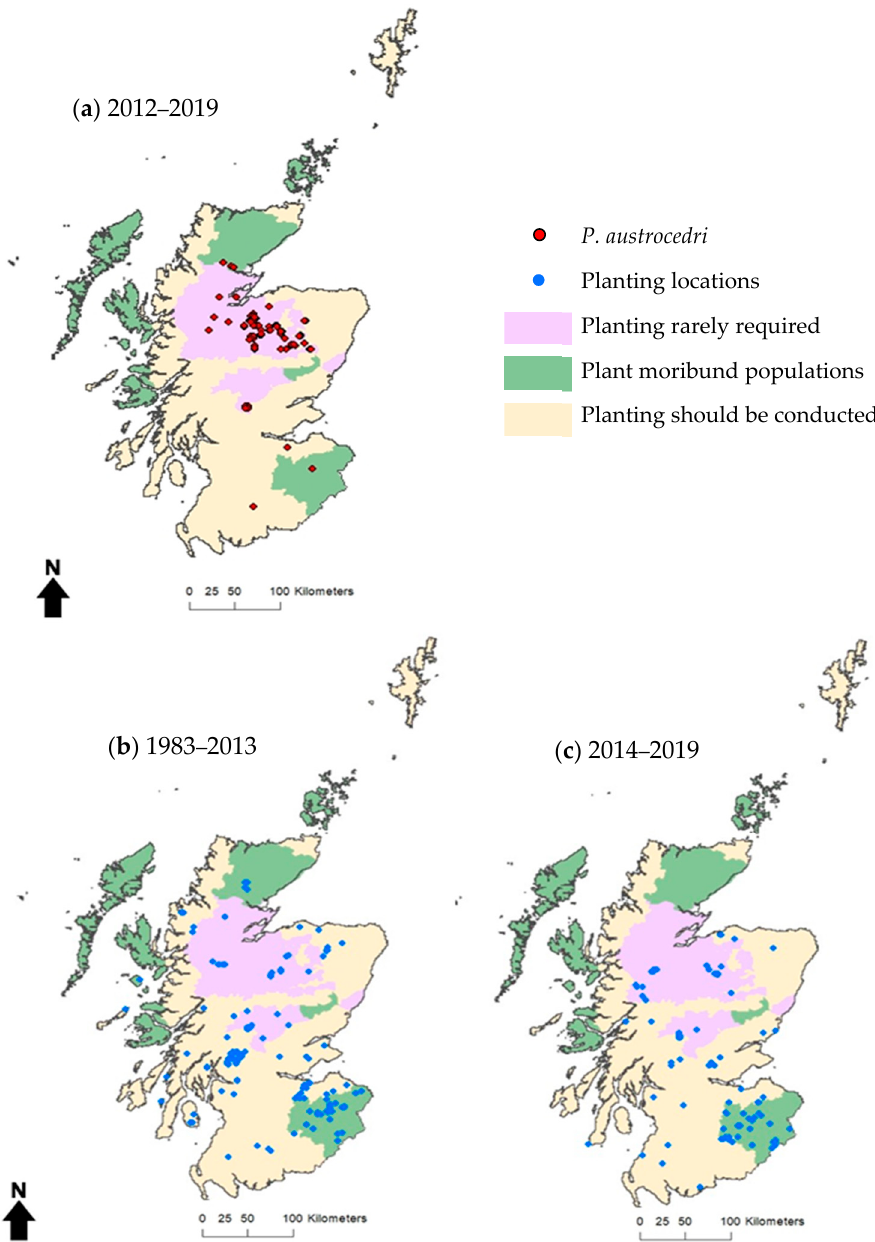
Figure 4. Distribution of tetrads (2 km × 2 km cells) across juniper conservation action zones for Scotland [33] that specifies different priorities for juniper planting. Maps a–c display tetrads containing ( a ) positive P. austrocedri detections, ( b ) wider